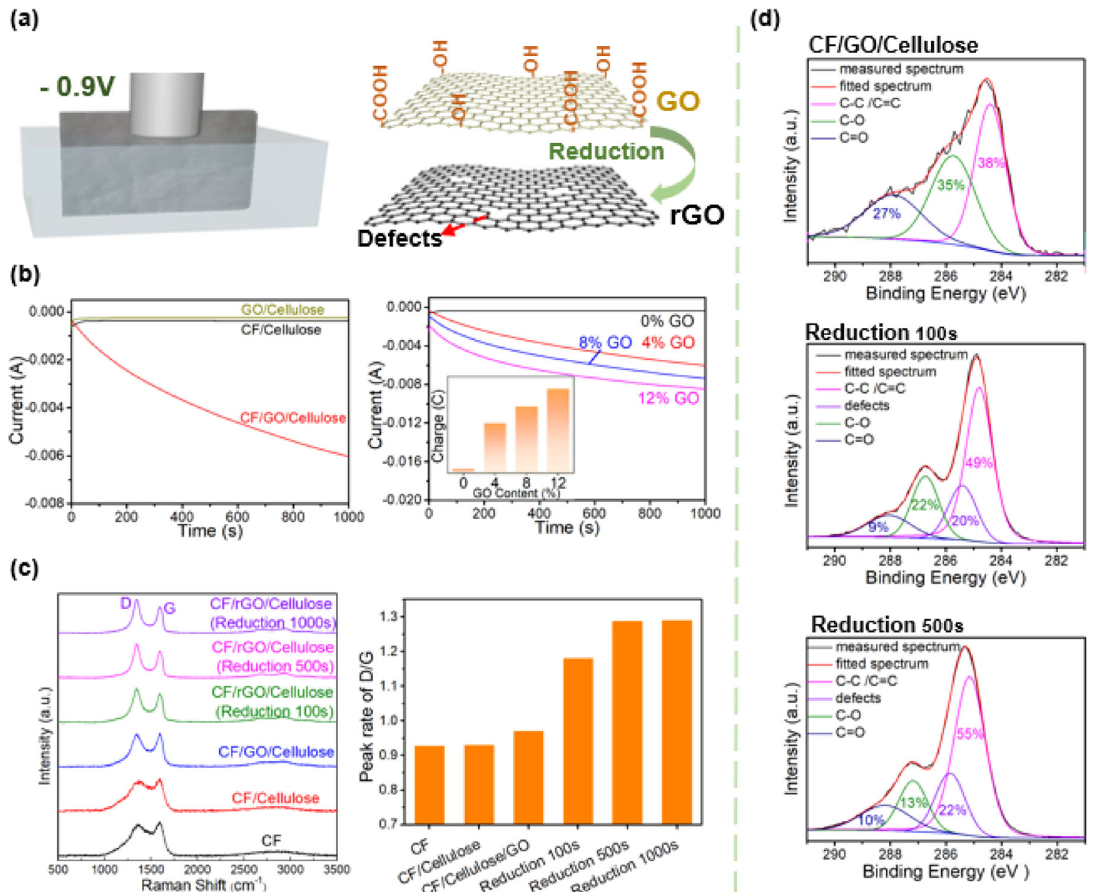
Fig. 3 Electrochemical reduction of GO in the composite paper. a Electrochemical reduction of graphene oxide. Schematic of electrochemical conversion of GO to reduced GO (rGO). b Controllable electrochemical reduction of GO in paper. Electrochemical measurements of current vs time (i – t) show that CF is required for reduction (CF provides the conducting network) and the reducing charge R idt ) increases with GO content (GO is the species being reduced). c Raman evidence on GO electrochemical reduction. transferred ( Q ¼ Raman spectroscopy provides molecular evidence for GO reduction and the generation of defects (indicated by D band) is believed to be important for electrocatalytic activity. d High-resolution XPS spectra of C 1 s. The high-resolution C 1 s peaks of XPS provide further molecular evidence for electrochemical